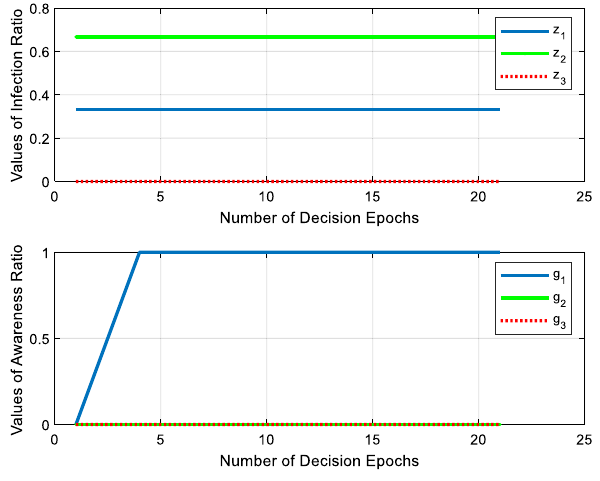
Fig. 8 Sample Trajectory without optimal control policy where z i is the infection ratio for network i and g i is the corresponding aware- ness ratio